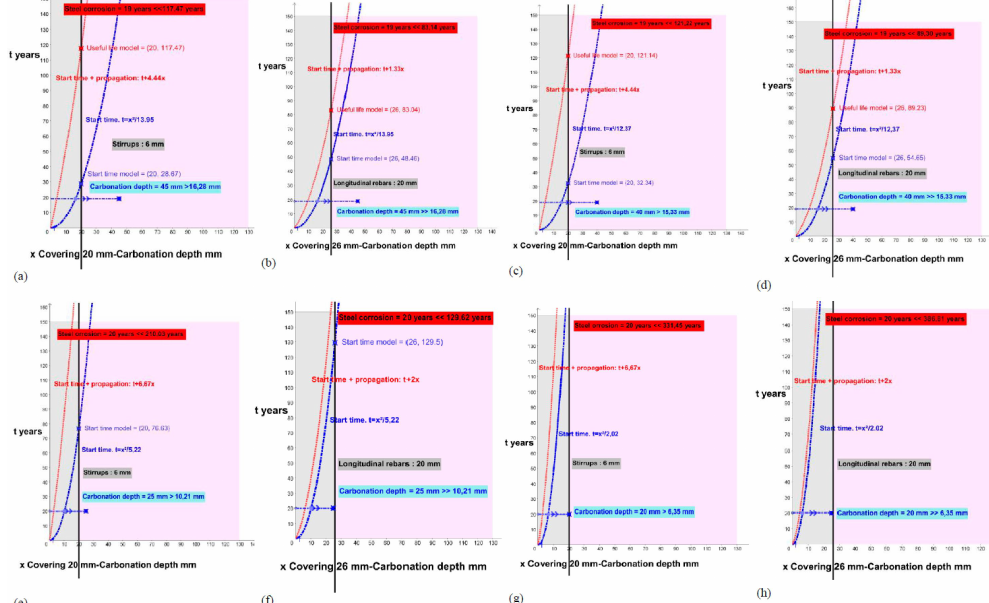
Figure 8. Start and propagation corrosion times in buildings 4T and 5T. ( a ) 4T_P2_ Stirrups. ( b ) 4T_P2_ longitudinal rebars. ( c ) 4T_P8_S Stirrups. ( d ) 4T_P8_ longitudinal rebars. ( e ) 5T_P3_ Stirrups. ( f ) 5T_P3_ longitudinal rebars. ( g ) 5T_P14_ Stirrups. ( h ) 5T_P14_ longitudinal